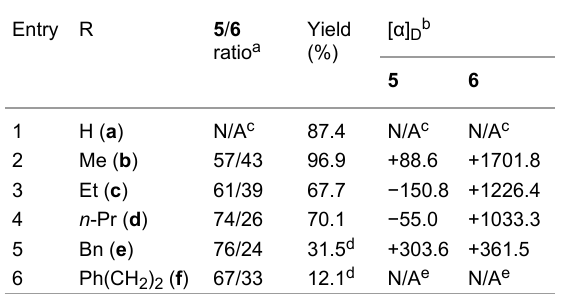
Table 1: Preparation of diastereomeric Ni(II) complexes 5a – f and 6a – f